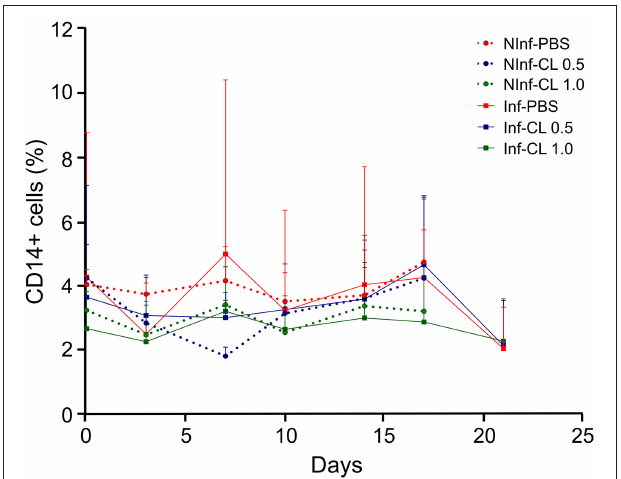
FIGURE 3 | Changes in blood monocyte counts during P. falciparum infection and CL administration. Monocyte quantification was performed by flow cytometry using anti-CD14-APC antibodies. Solid lines represent the mean and standard deviation. %: percentage of CD14 + cells in total number of peripheral blood monocuclear cells (PBMC). NInf, non-infected control groups; Inf, P . falciparum -infected groups.